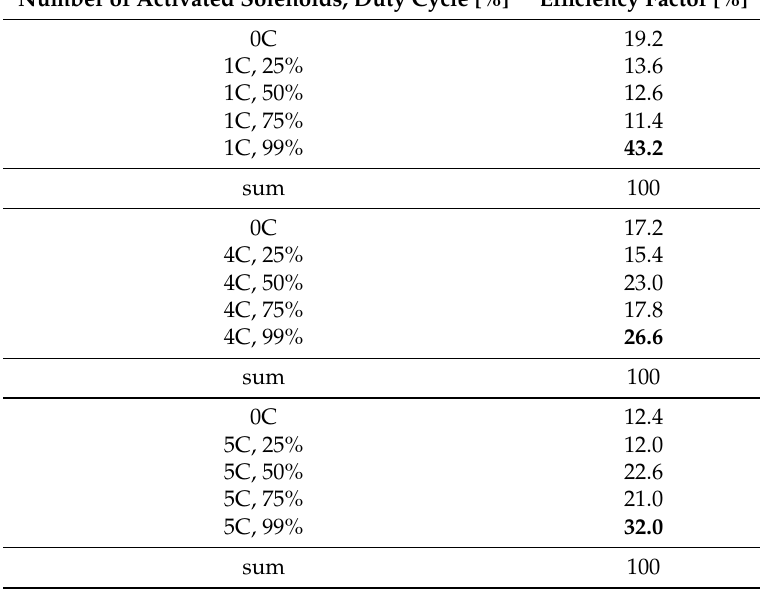
Table 5. Efficiency factors calculated for MFC3, depending on the number of solenoids and the value of duty cycle of a PWM